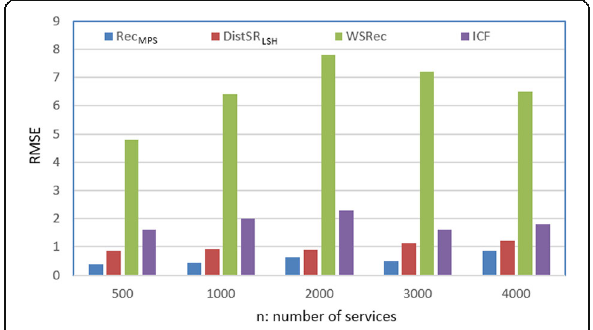
Fig. 1 Accuracy comparisons (w.r.t. n ) ( m = 142). DistSR LSH , Rec MPS , WSRec,